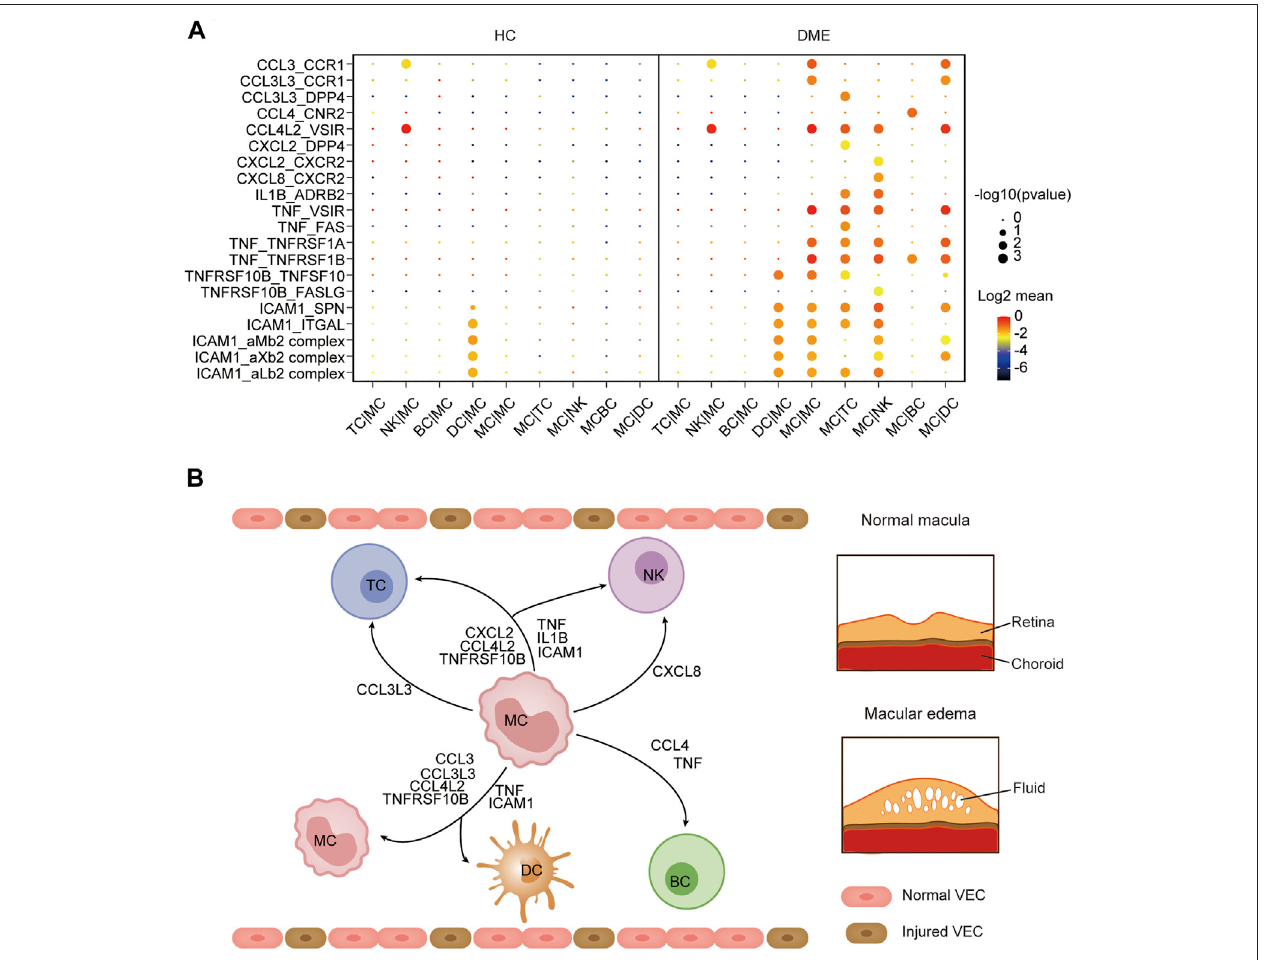
FIGURE6| Cell-cell communication wasenhancedamong MC and other immune cells in DME. (A) Dot plot ofthepredictedinteractionsbetween monocytes and theindicatedimmunecelltypesintheHCandDMEgroup. (B) Summaryillustrationdepictingthepotentialcytokine-receptorinteractionsbetweenMCandothertypesof peripheral immune cells in the